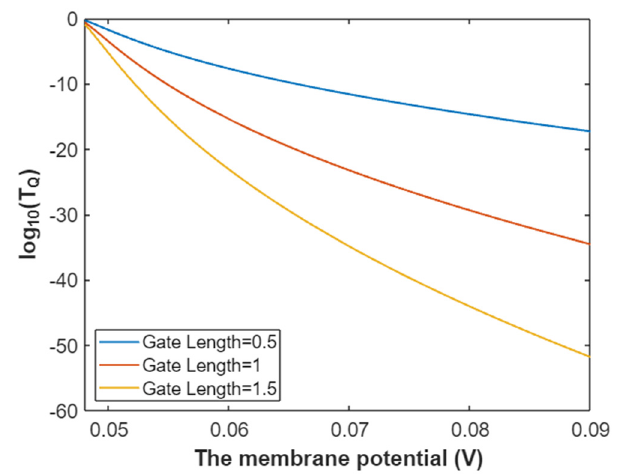
Figure 6. The relationship between membrane potential and the common logarithm of tunneling